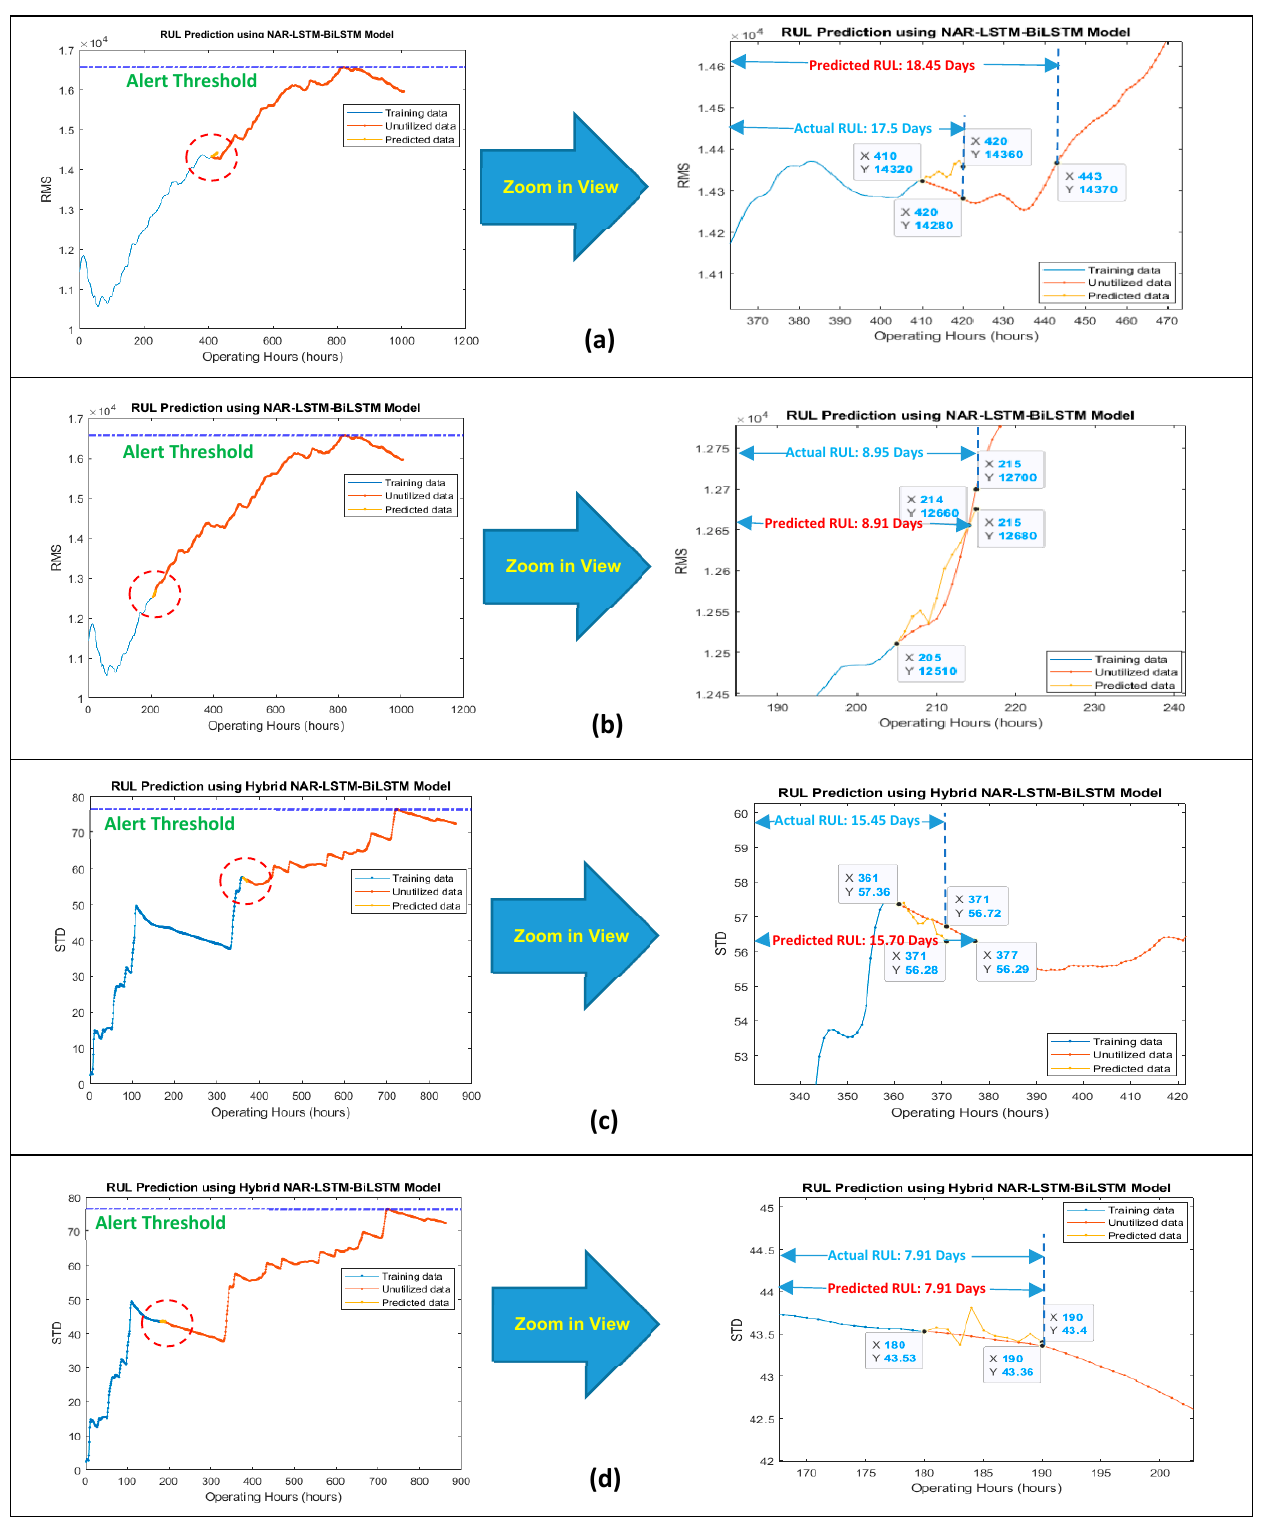
Figure 11. Prediction of short-term RUL for the next 10 h of the slurry pump using data sets 2014 for ( a ) 50% and ( b ) 25% data of degradation trends for training purpose, and dataset 2017 for ( c ) 50% and ( d ) 25% data of degradation trends for training